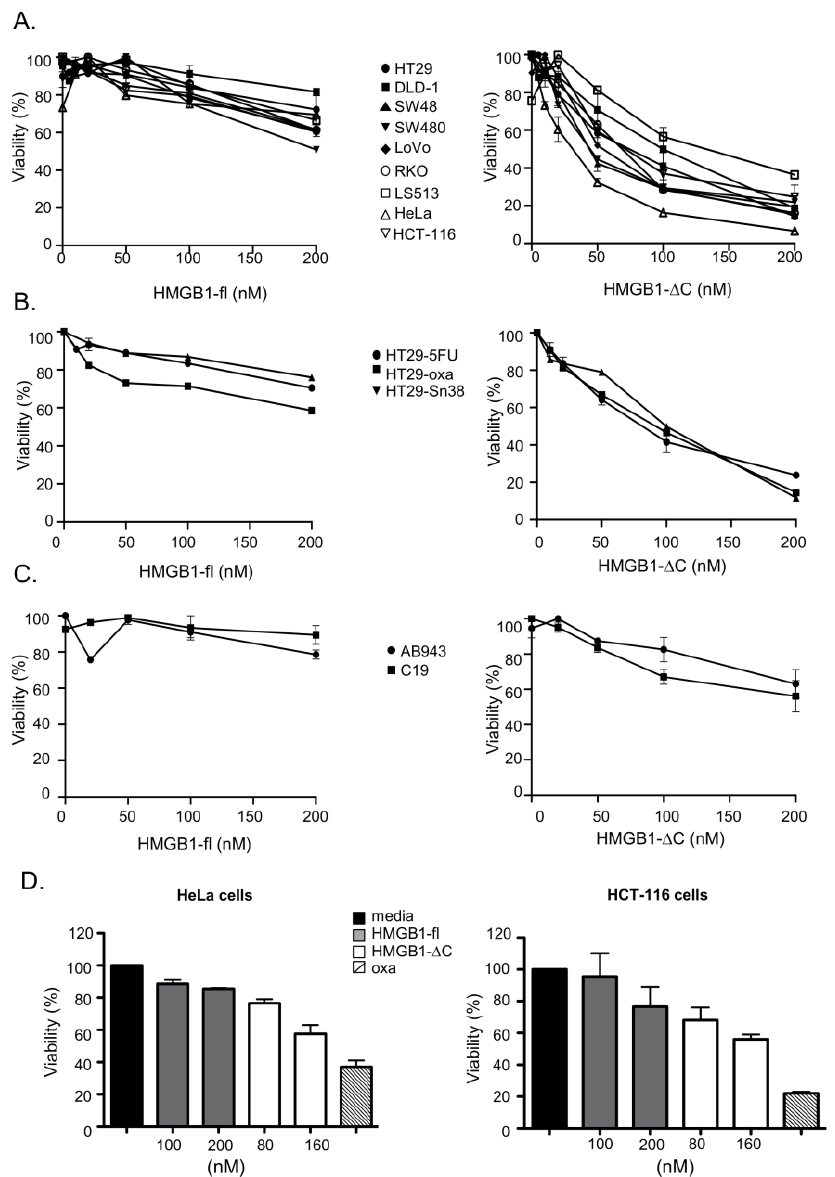
Figure 2. Cell viability assay of HMGB1-fl and HMGB1- ∆C on human cancer and fibroblastic cell lines. ( A – C ) Two-dimensional cell viability assay: ( A ) CRC (HT-29, DLD-1, SW48, SW480, LoVo, RKO, LS513) and cervix carcinoma (HeLa) cells were treated for 5 days with increasing concentrations of HMGB1-fl or HMGB1- ∆C (range : 5 – 200 nM) and cell viability assessed by the MTT assay; ( B ) HT-29 cells resistant to 5-fluorouracil (HT-29-5-FU), oxaliplatin (HT29-Oxa) and irinotecan (HT-29-Sn-38) were treated for 5 days with increasing concentrations of HMGB1-fl or HMGB1- ∆C (range : 5 – 200 nM) and cell viability assessed by the MTT assay; ( C ) immortalized fibroblastic cells (C19 and AB943) were treated for 5 days with increasing concentrations of HMGB1-fl or HMGB1- ∆C (range 5 – 200 nM) and cell viability assessed by the MTT assay. ( D ) Three-dimensional cell viability assay: HeLa and HCT-116 carcinoma cells were cultured in 3D and then treated with increasing concentrations of HMGB1-fl (100 nM, 200 nM) and HMGB1- ∆C (80 nM, 160 nM) for 4 days. Cell viability was assessed by the CellTiter-Glo 3D assay. Oxaliplatin (Oxa, 4 µM) was used as a positive control. SDs are indicated by error bars when they exceed symbol size.